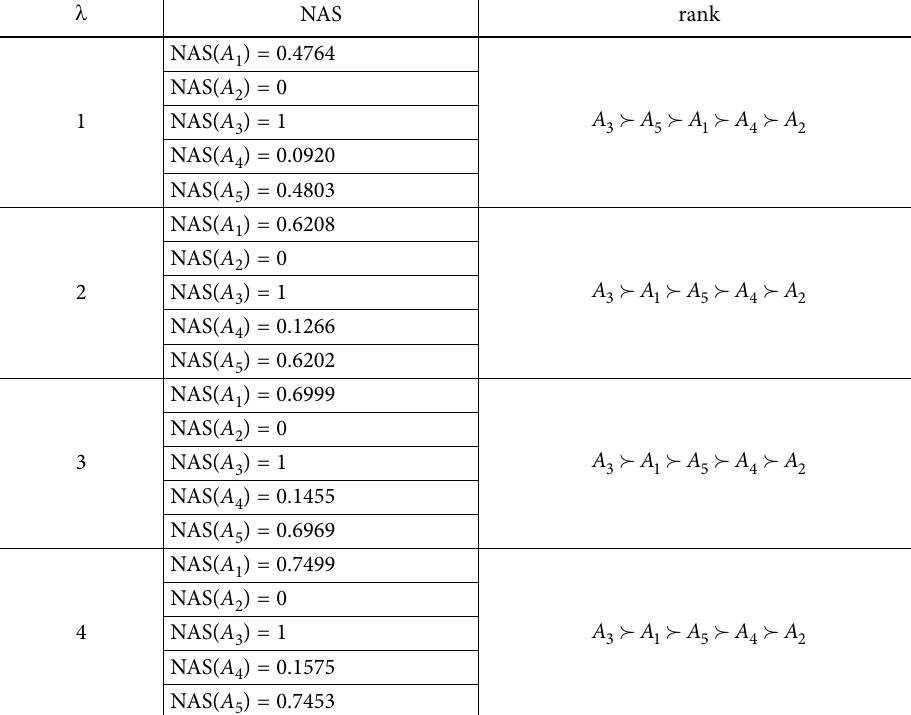
Table 19. the rank results of different values of l NAS